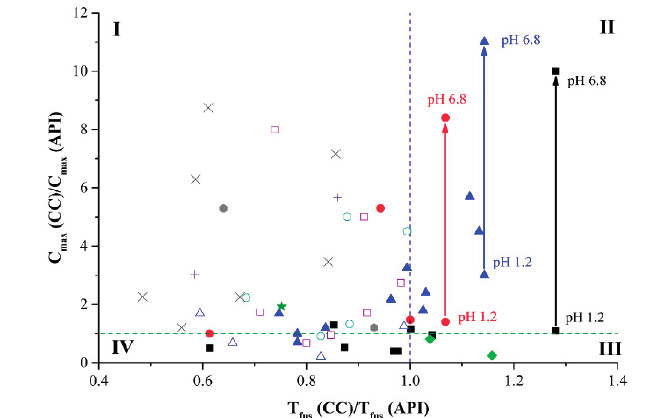
Figure 8. Diagram of the influence of API melting temperature change in cocrystals and salts with dicarboxylic acids on their solubility. The cocrystals and salts with different acids as co-formers are represented by the following symbols: with oxalic (  ); with malonic (  ); with fumaric ( ■ ); with maleic ( ● ); with succinic ( ▲ ); with tartaric (  ); with glutaric (  ); with adipinic ( □ ); with pimelic (  ); with suberic ( ○ ); with sebacic (  ) acids. The green dash line corresponds to the cases when the cocrystal/salt solubility is equal to API solubility. The blue dash line corresponds to the case when the cocrystal/salt melting temperatures are equal to the API